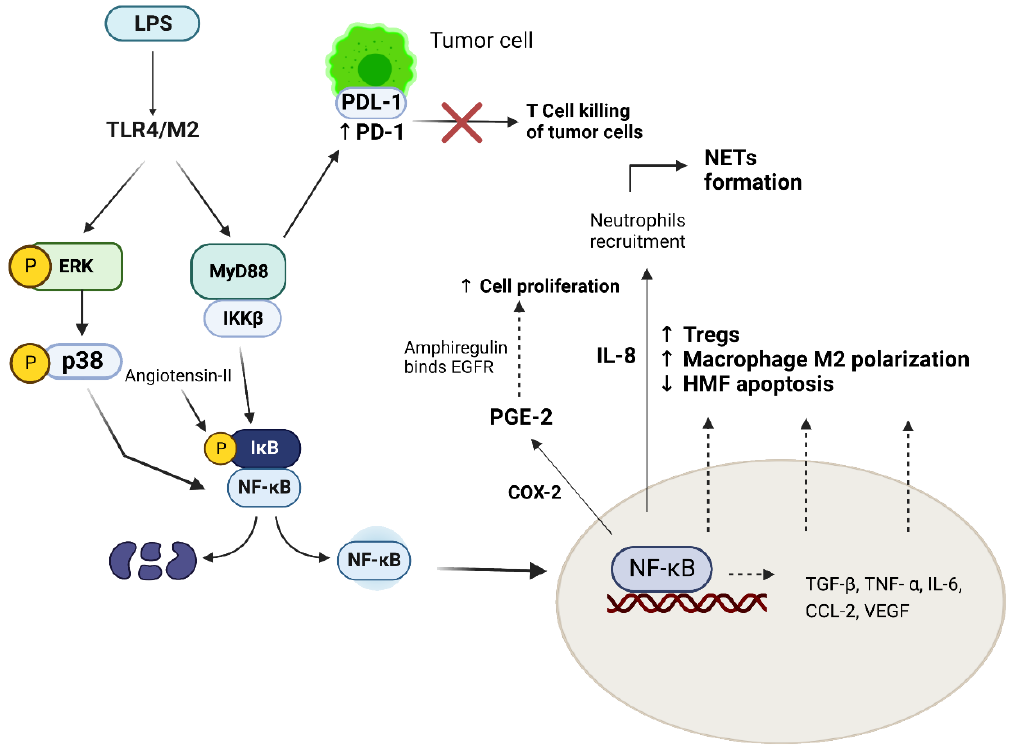
Figure 2. Molecular pathways involved in tumor development and progression. LPS, through TLR- 4, activates MyD88 and MAPK/ERK/p38 pathways, both capable of promoting NF-kB nuclear translocation — in particular, through MyD88 pathway, IKKB phosphorylates IkB, which detaches from NF-KB, allowing nuclear translocation. This mechanism is favored by autocrine Angiotensin- II. Once in the nucleus, NF-kB activation leads to the transcription of multiple cytokines.